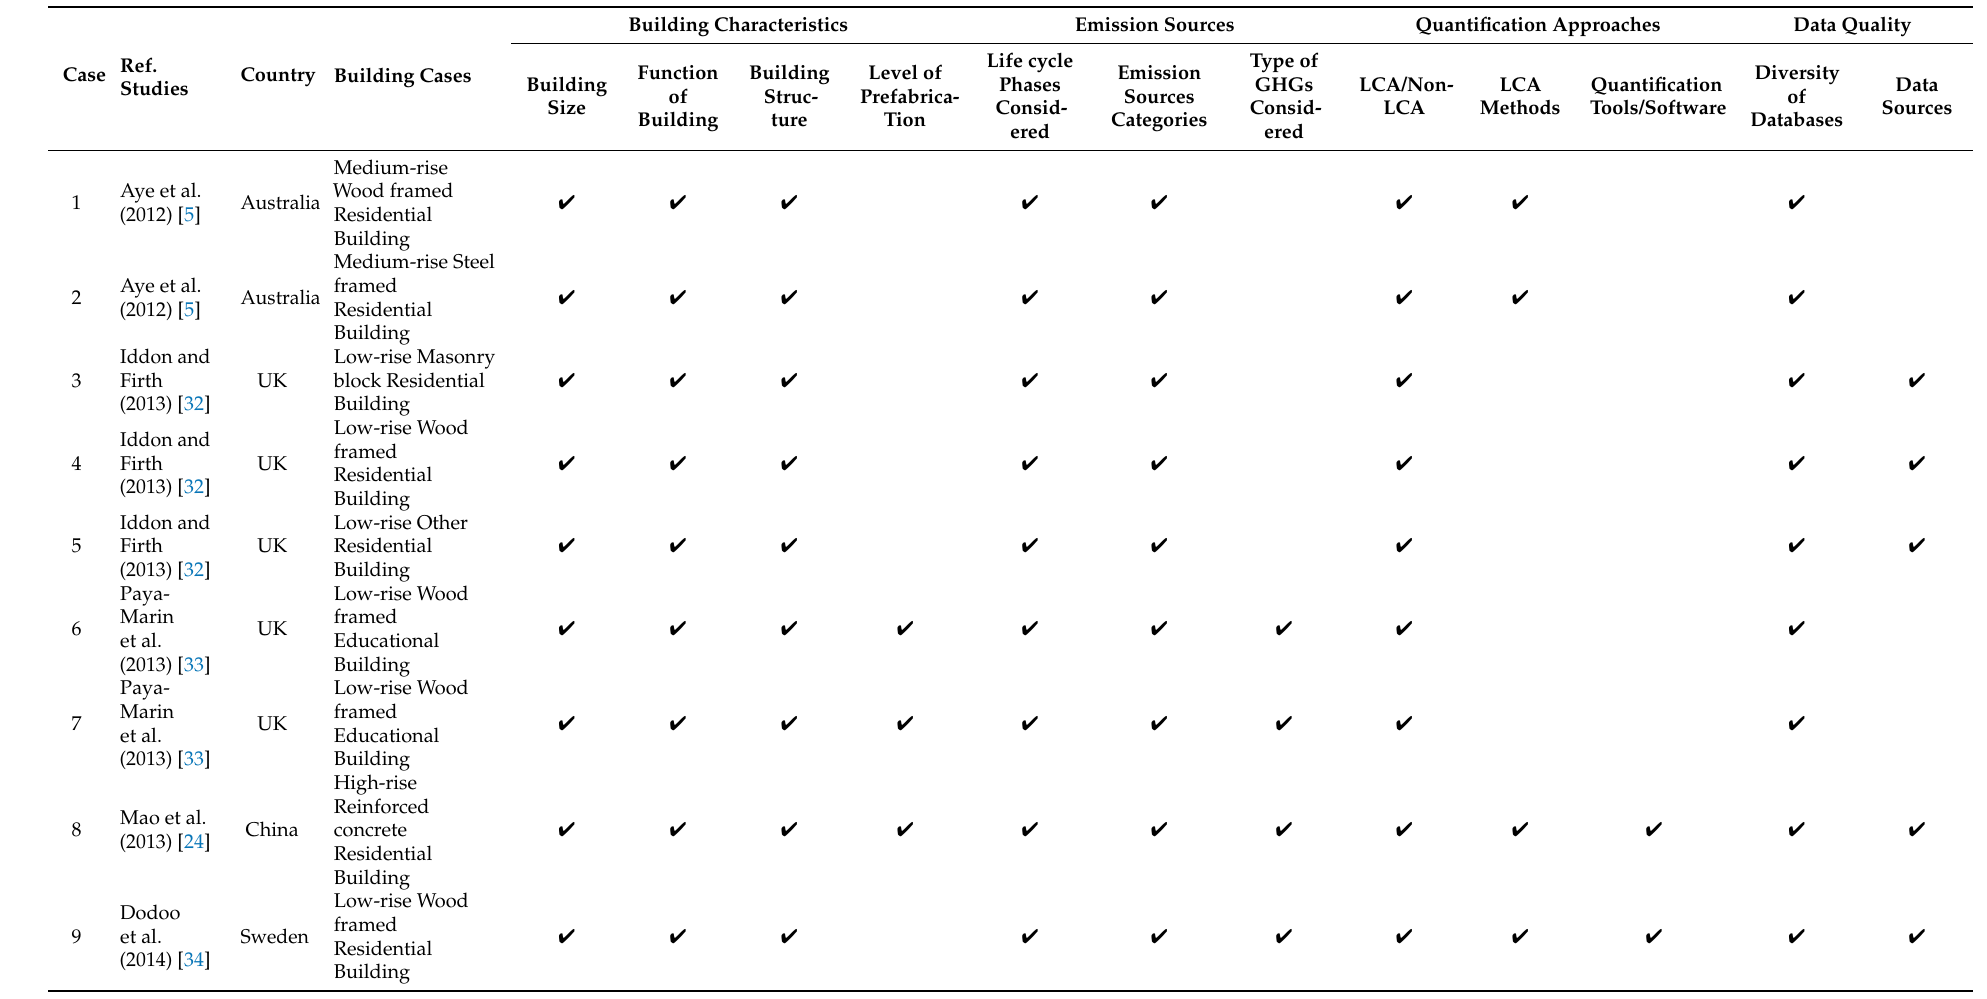
Table A1. Overview of reviewed prefabricated building cases and their availability of data for